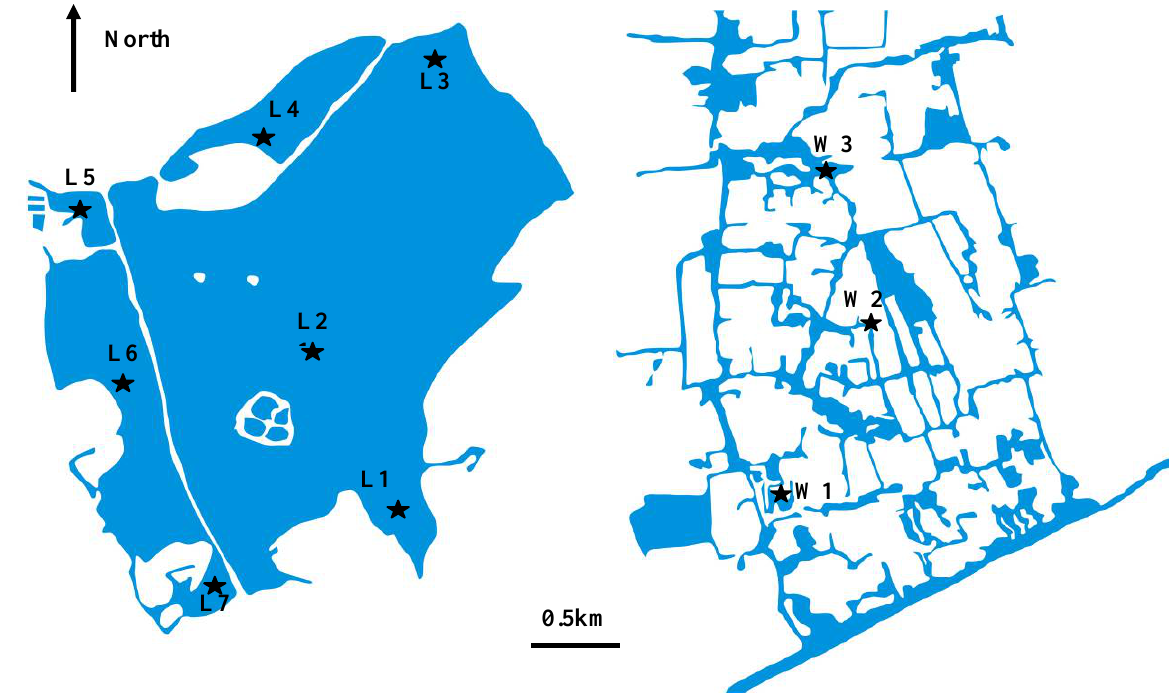
Figure 5. The geographic location of the sampling